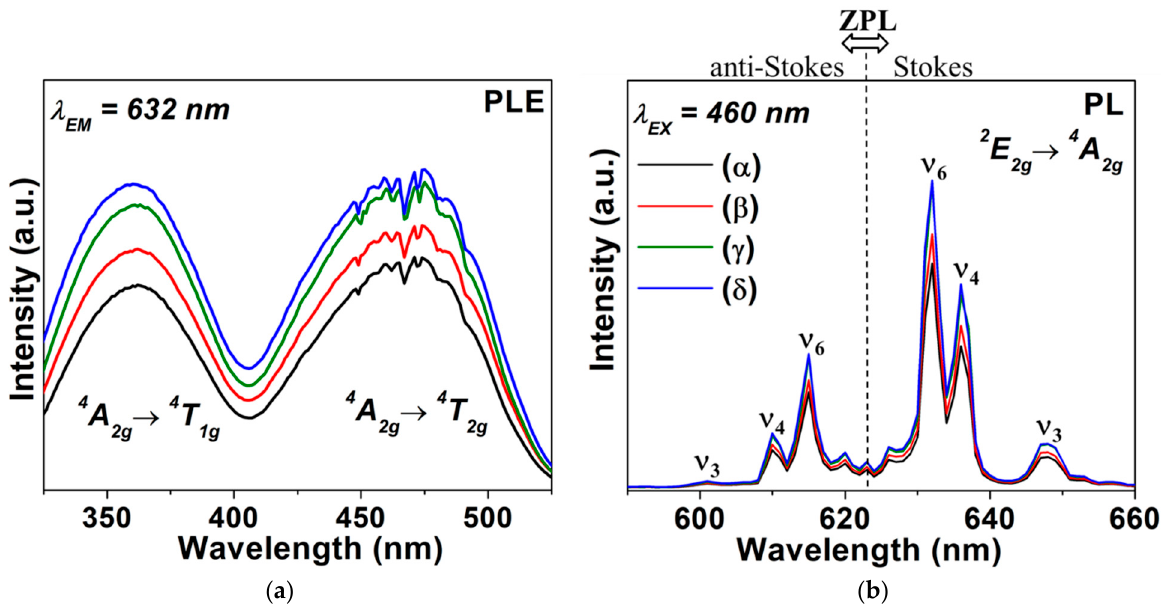
Figure 4. ( a ) PLE spectra and ( b ) PL spectra of KTFM prepared with various OA/SDS ratios of ( α ) 0.0, ( β ) 2.0, ( γ ) 6.0 and ( δ ) 10.0.